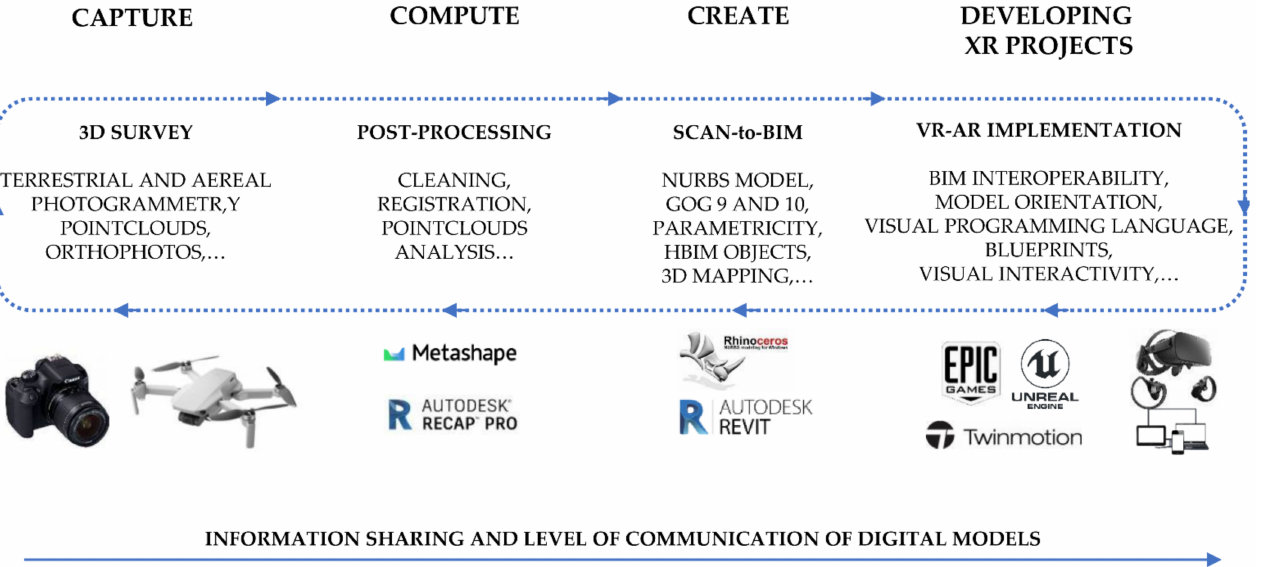
Figure 1. The proposed digital workflow applied to the research case